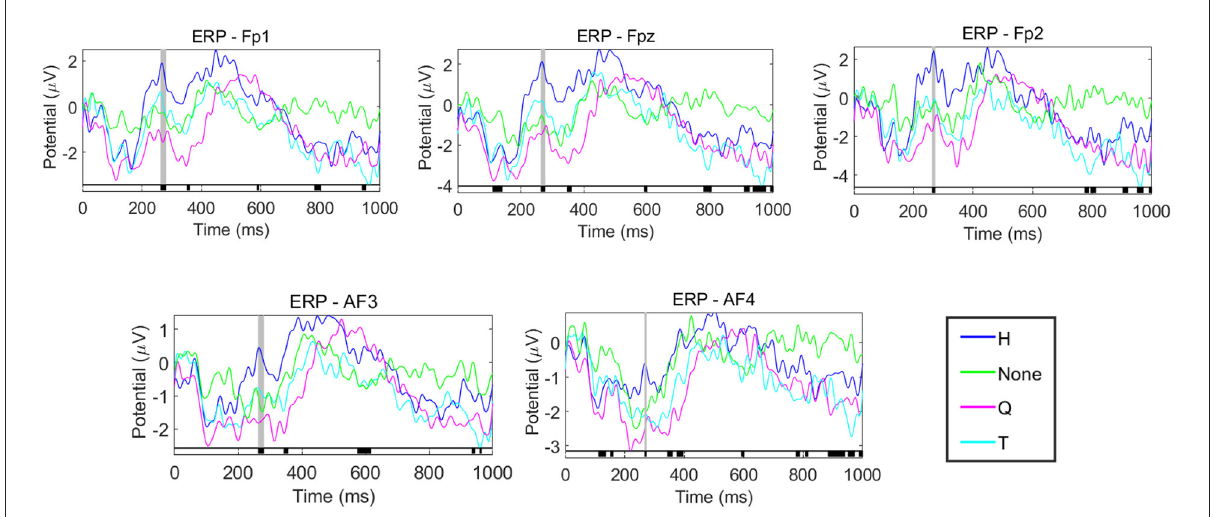
FIGURE8 ERP analysis of prefrontal lobe electrode. From top to bottom and from left to right are the ERP waveforms of FP1, FPz, FP2, AF3, and AF4, respectively. The blue, green, purple and cyan curves represent the ERP waveforms of the decision task after the stimuli of H, None, Q, and